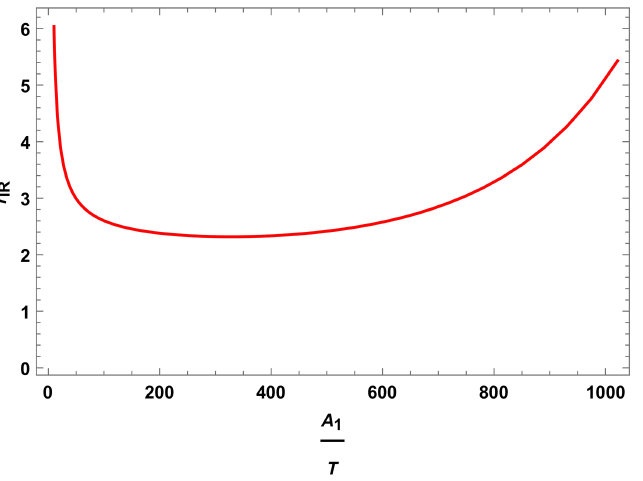
) vs r , for the toy model. From top to bottom, the p are shown in the right). The vertical gray line represents the T . 85